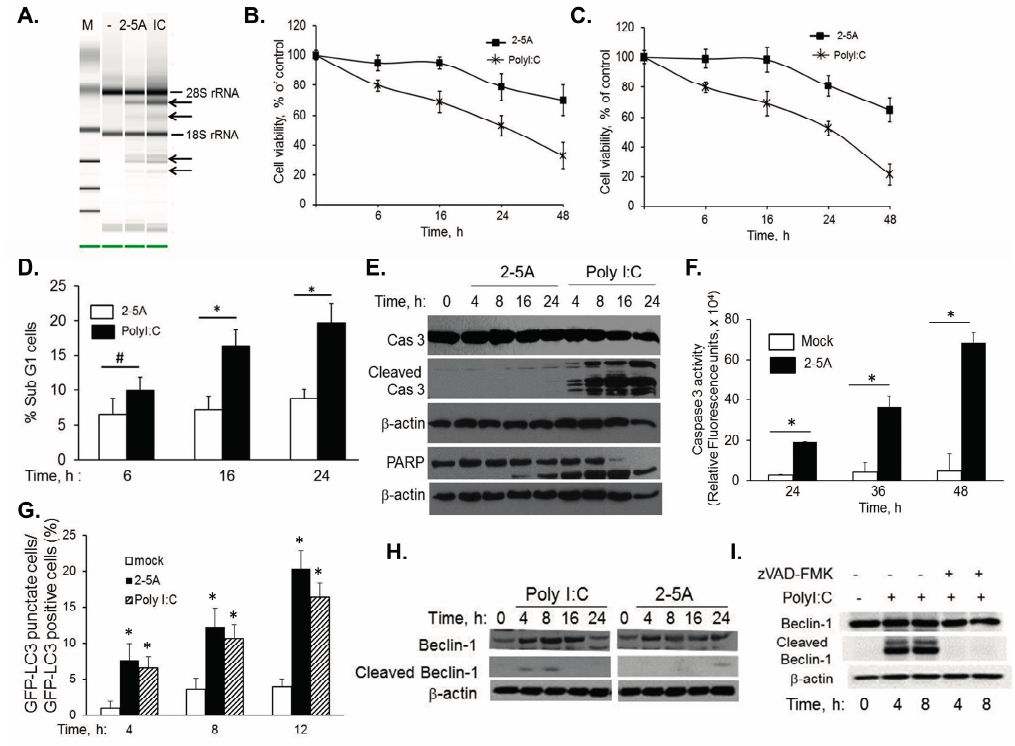
Figure 1. Cleavage of Beclin-1 in RNase L-mediated cross-talk between autophagy and apoptosis. HT1080 cells were transfected with 10 µM of 2–5A or 2 µg/mL of PolyI:C and ( A ) RNase L-mediated cleavage of rRNA (arrows) was analyzed on RNA chips using the Agilent Bioanalyzer 2100 after 6 h. Cell viability was determined at indicated times by ( B ) MTT colorimetric assays, ( C ) trypan blue dye exclusion assay normalized to control cells or ( D ) uptake of PI by dying cells as measured by flow cytometry after staining with PI. Results are representative of three independent experiments performed in triplicate ± SD; ( E ) Cleavage of Caspase 3 and PARP in cell lysates from 2–5A or PolyI:C transfected cells was analyzed on immunoblots and normalized to β -actin levels; ( F ) Caspase 3/7 activity was measured in 2–5A transfected cells at indicated times using rhodamine-labeled caspase-3 and -7 substrate (ApoONE homogenous caspase-3 and -7 assay kit (Promega). Results are representative of three independent experiments performed in triplicate ± SD; ( G ) GFP-LC3 expressing HT1080 cells were mock treated, transfected with 10 µM of 2–5A or 2 µg/mL of PolyI:C for indicated times and the percentage of GFP + cells showing puncta formation compared to mock treated cells was analyzed. Results shown represent mean ± SEM for three experiments and at least 100 cells were analyzed per assay, p values are shown as compared with mock treated cells; ( H ) Cleavage of Beclin-1 was monitored in response to 2–5A or PolyI:C for indicated times on immunoblots and normalized to β -actin levels; ( I ) HT1080 cells expressing Flag-Beclin-1 were pretreated with zVAD-FMK (20 µM) or not for 1 h followed by 2 µg/mL of PolyI:C for indicated times. Cleavage of Beclin-1 was determined on immunoblots and normalized to β -actin levels. Results are representative of three independent experiments. Student’s t test was used to determine p values. * p < 0.001, # p <